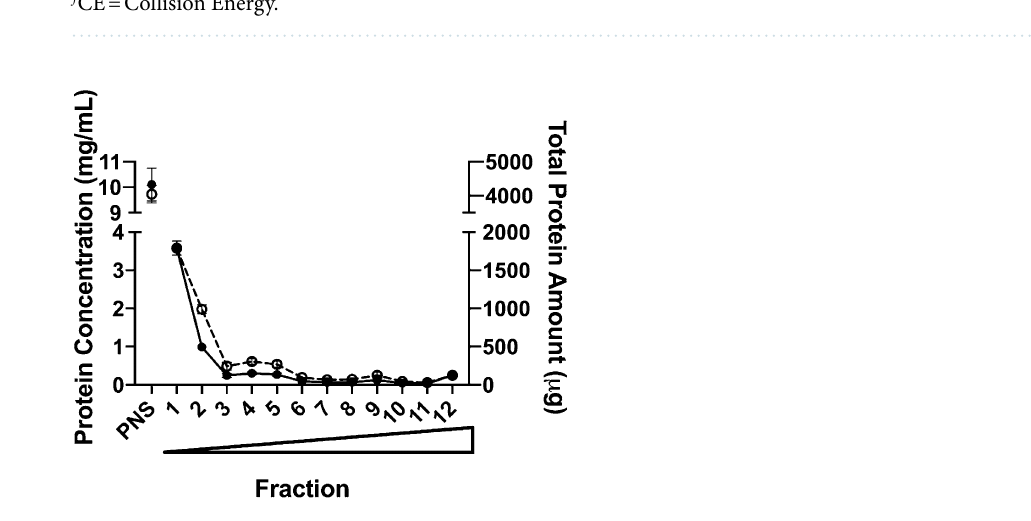
Figure 1. Protein concentration and total protein amount present in PNS and each isolated sucrose fractions. Solid circles represent protein concentration (mg/mL), and open circles represent total protein amount isolated (µg). Circles represent the average value from three human liver donors, and error bars represent the standard deviation. Wedge indicates increasing sucrose % from fraction